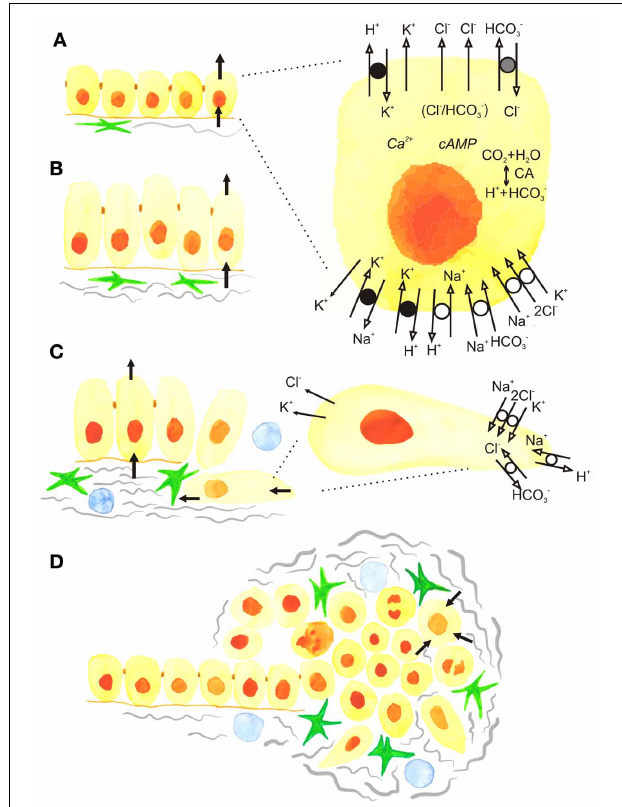
FIGURE 1 | The development of epithelial cancer and roles of ion transport and cell volume. (A) Normal secreting epithelium showing net movementsof ions and fluid across the basolateral and luminal membranes. Black arrows show the movement of ions and fluid across cell membranes. The insert shows the detailed model of a cell with basic ion channels and transporters that operate, for example, in pancreatic ducts, but are also applicable to other secreting epithelia. The luminal Cl − channels include CFTR and TMEM16A/ANO1, as well as a SLC26 family Cl − /HCO − 3 exchanger. The basolateral membrane contains the Na + /K + /2Cl − transporter NKCC1, SLC7 family Na + -HCO − 3 cotransporters (NBCs), and the Na + /H + exchanger NHE1. The epithelium also expresses H + /K + pumps, as well as several types of K + channels such as IK-KCa3.1, BK-KCa1.1, KCNQ1 and voltage-activated K + channels, some of which may be expressed on both luminal and basolateral membranes. The major Ca 2 + and cAMP signalling pathways are not elaborated and for simplicity, Ca 2 + -channels/transporters and aquaporins are not included. (B) Carcinogenesis and postulated dysregulation of cells volume and secretion. Increased activity of fibroblastic cells, such as cancer associated fibroblasts (CAFs) and pancreatic stellate cells (PSCs) (green). (C) The epithelial-to-mesenchymal (EMT) transition showing cells that loose apico-basal polarity and the appearance of some ion transporters from the lumimal membrane in the rear of the cells and some from the basolateral membrane in the leading edge, contributing to driving cell migration. (D) Progression to cancer, showing tumor with extensive fibrosis (gray), fibrogenic cells (green) and immune cells (blue). (Blood vessels are not shown). In the center of the tumor cells may die, while surroundingcells are proliferating and cell volume and corresponding ion transport is up-regulated (see the text).